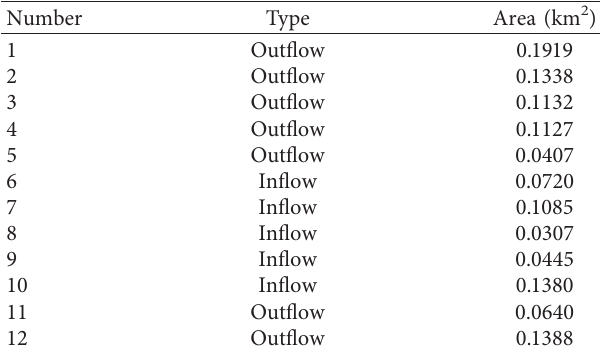
Table 1: Watershed